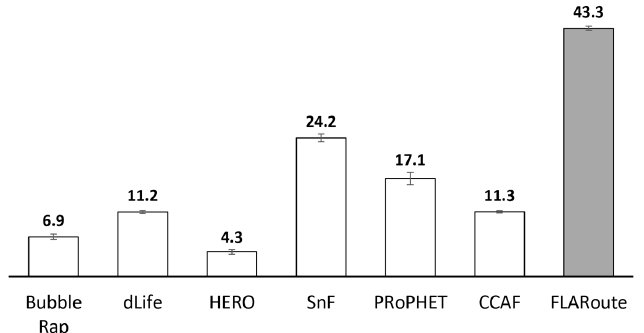
Figure 10. Energy distribution (in %, i.e., (cid:2009) × 100) of different routing techniques.